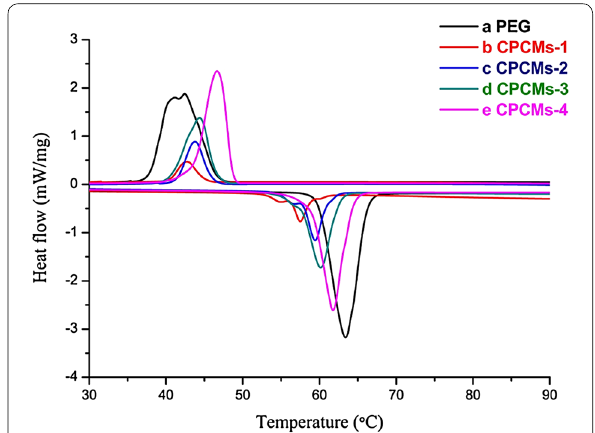
Fig. 9 The DSC curves of (a) PEG, (b) CPCMs‑1, (c) CPCMs‑2, (d) CPCMs‑3, and (e) CPCMs‑4